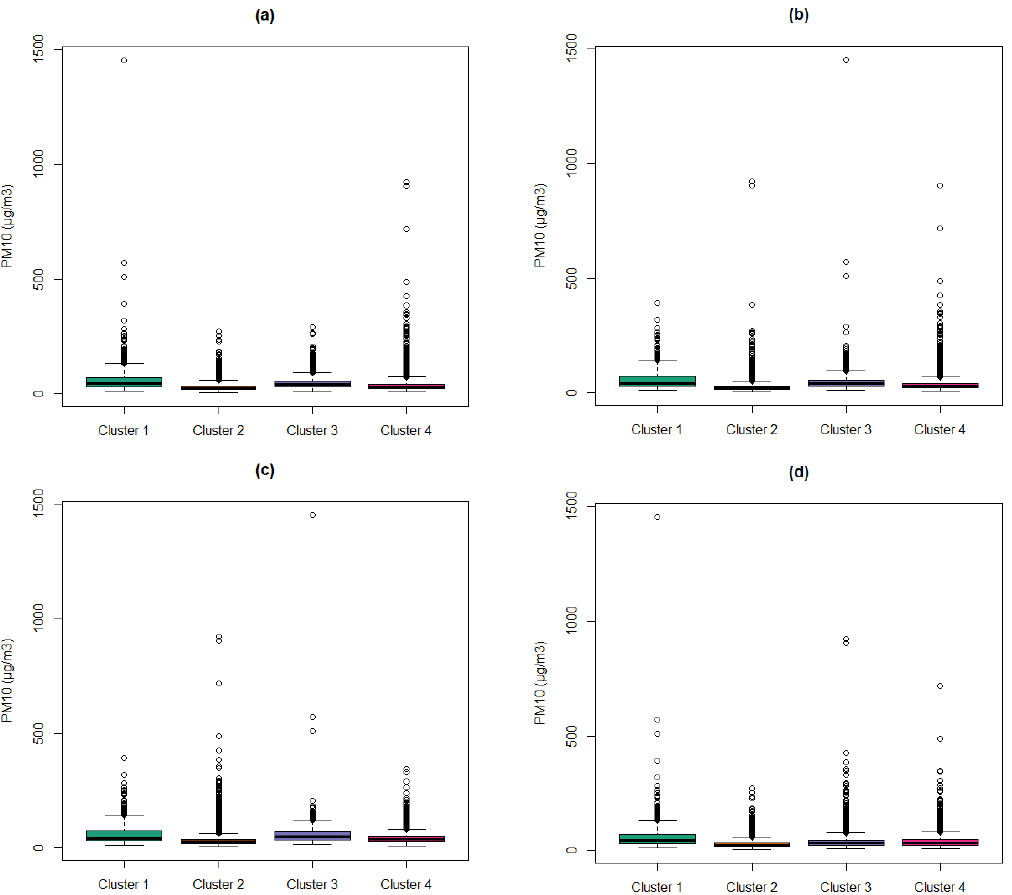
Figure 17. Boxplots for Malaysia PM 10 value ( µ g/m 3 ) according to clusters based on four clustering algorithms for daily maximum data: ( a ) DTW with k-Means; ( b ) DTW with PAM; ( c ) DTW with hierarchical; ( d ) DTW with FKM. Lower whisker represents minimum observation, lower hinge represents lower quartile, the middle line represents median, upper hinge represents upper quartile, and upper whisker represents maximum observation. Table 4. Minimum, lower quartile, median, upper quartile and maximum (below upper fence) ob- servations of PM 10 according to clusters based on four clustering algorithms for daily maximum data extracted from the corresponding boxplots.